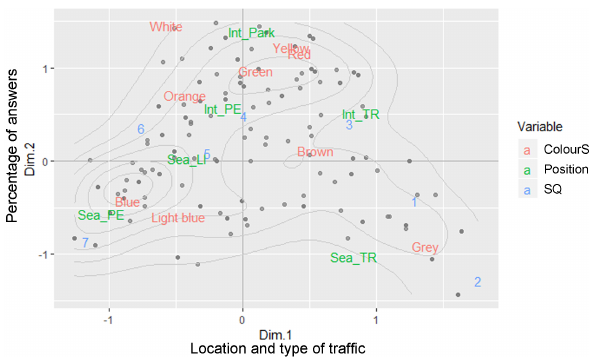
Figure 11: Output of the multiple correspondence